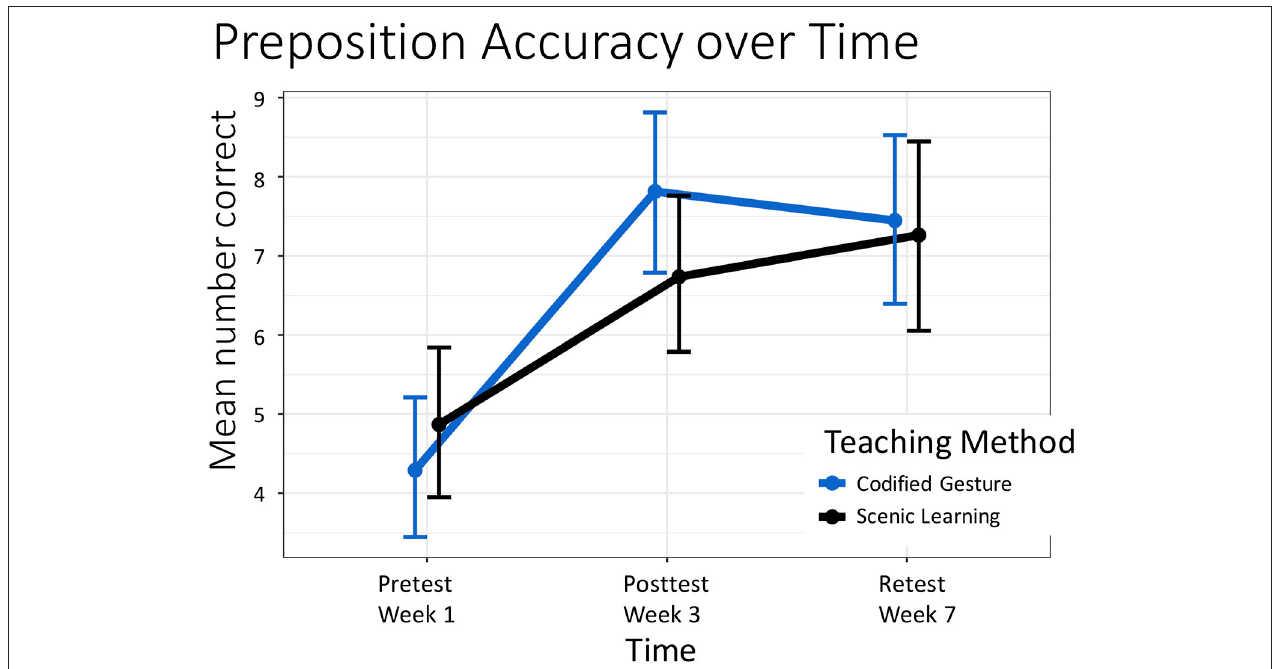
FIGURE 3 | Change in mean spatial term accuracy over time between teaching methods. The x- axis plots the three tests, pretest (before instruction), post (1 week after instruction), and retest (5 weeks after instruction) for the codified gesture (CG) and scenic learning (SL) experimental groups. The y- axis plots the mean number of correct test items per teaching method. For the sake of clarity, error bars plot unadjusted 95% confidence intervals.